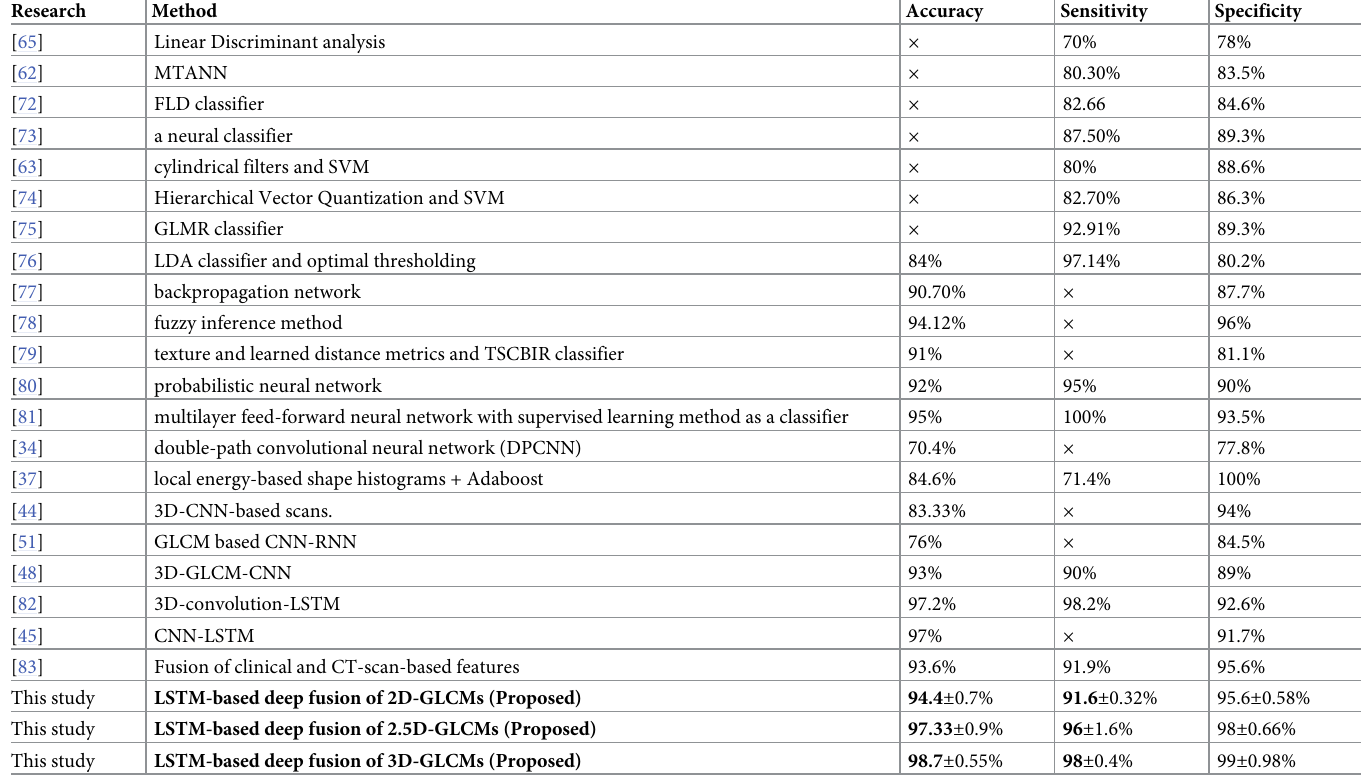
Table 4. A comparison between the proposed fusion methods for different modes of GLCM computation and the recently proposed classification methods regard- ing the accuracy, sensitivity, and specificity metrics.